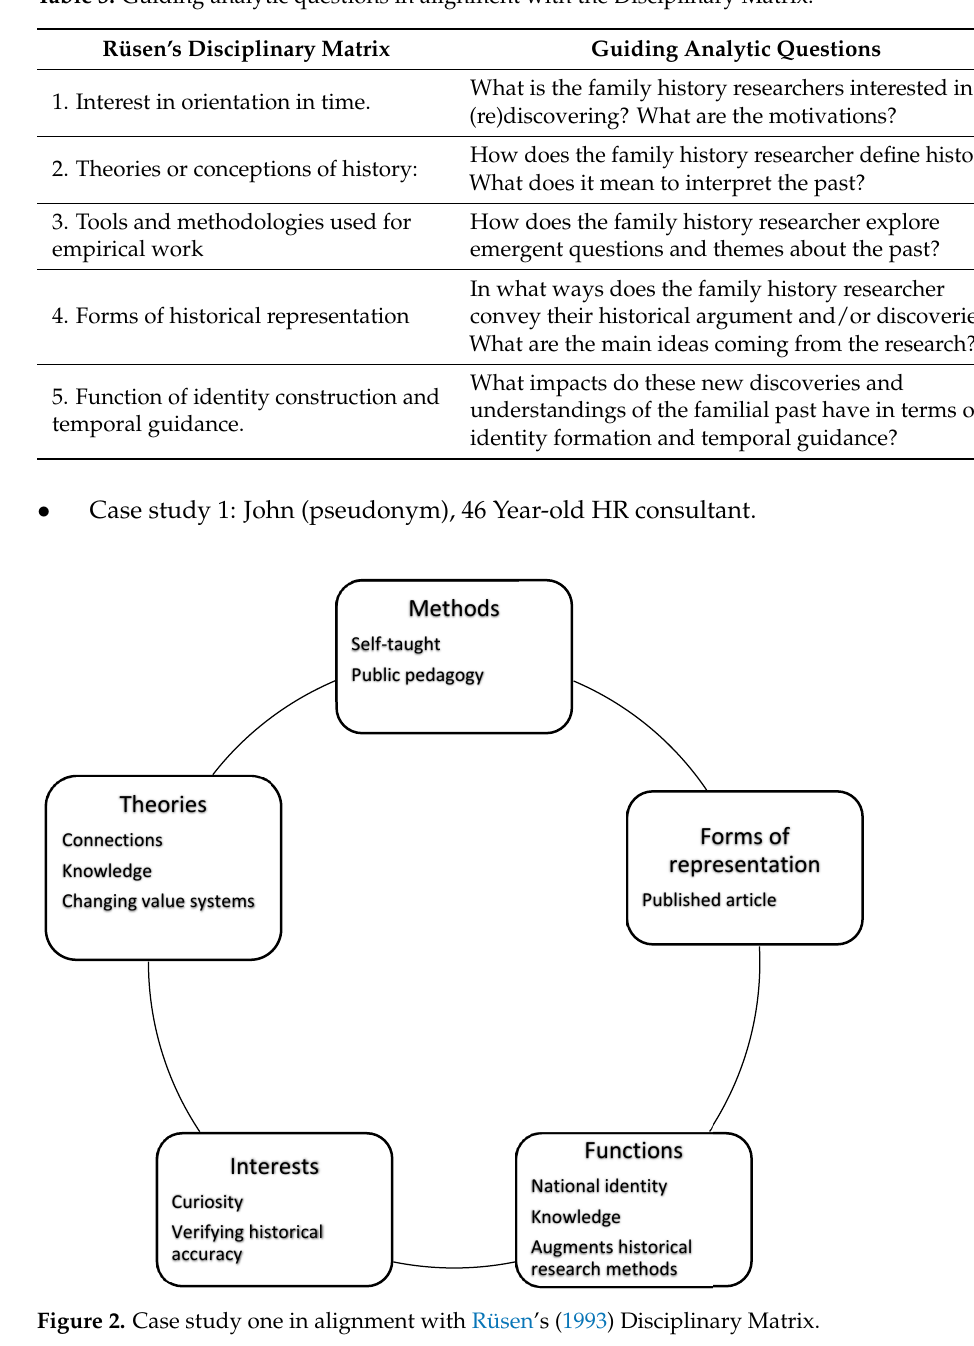
Figure 2. Case study one in alignment with Rüsen’s (1993) Disciplinary Matrix.